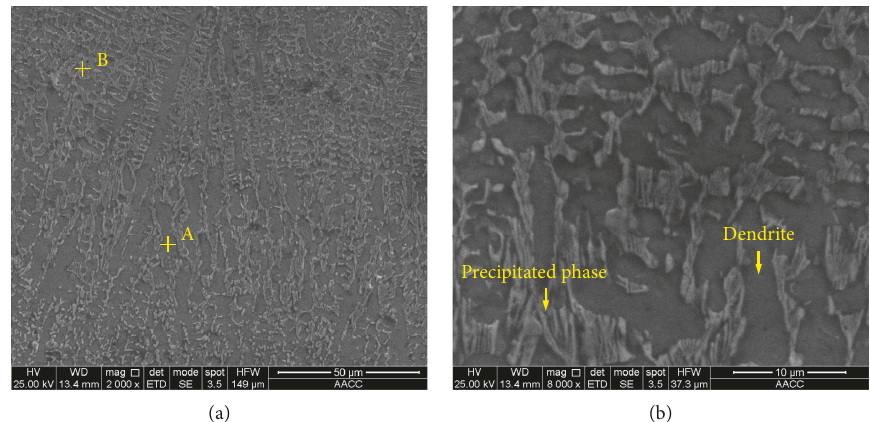
Figure 6: Cross-sectional SEM micrographs of NiCoCrAlY laser track. (a) 2000 × image showing the location of EDS testing points and (b) 8000 × image showing the dendritic